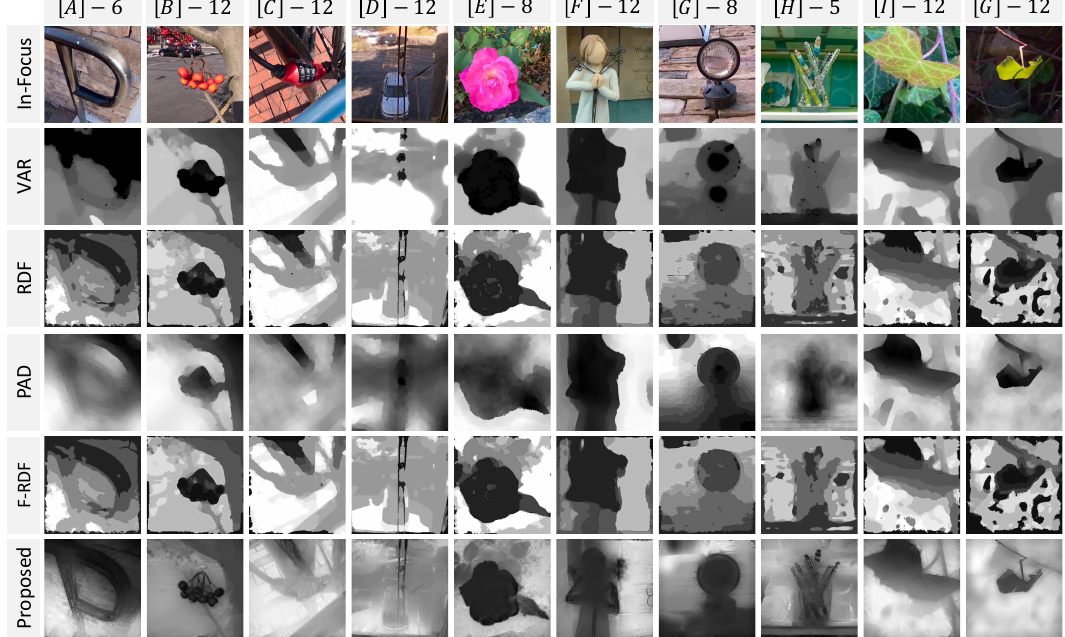
Figure 16. Qualitative evaluation on LFSD dataset [28] with state-of-the-art methods. The top of each sample has the number of used frames. The proposed method provide more accurate depth with clean edges, even at a complex scene, such as shiny object ( G ), more clean details on ( B , D , F – H ), and proposed method kept structure of the scene on ( A , C , E ) samples better than other